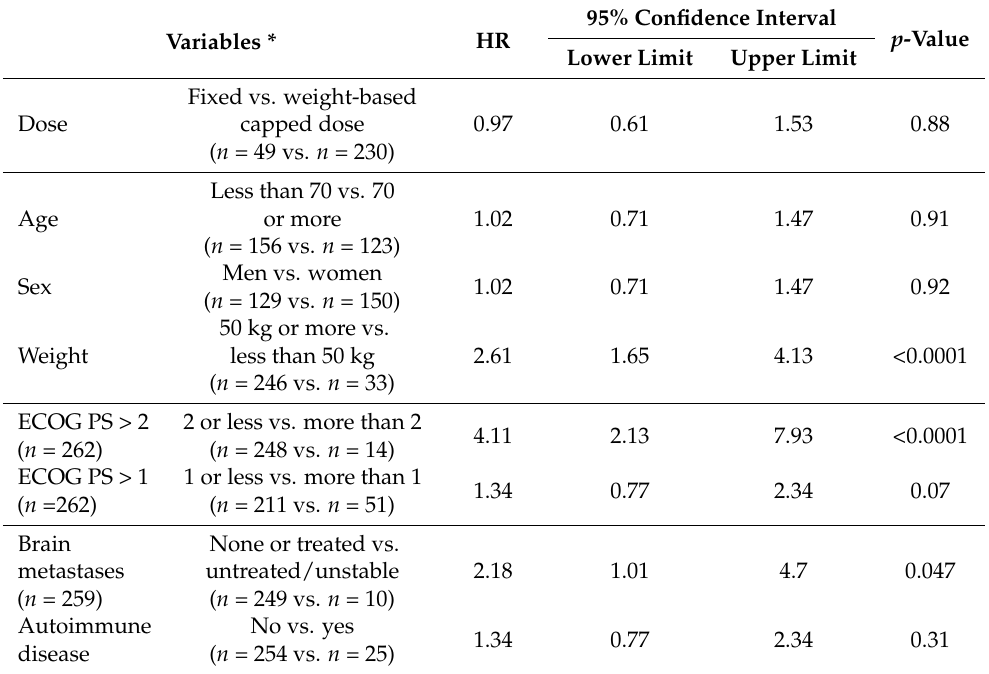
Table 2. Univariate Cox regression and impact on overall